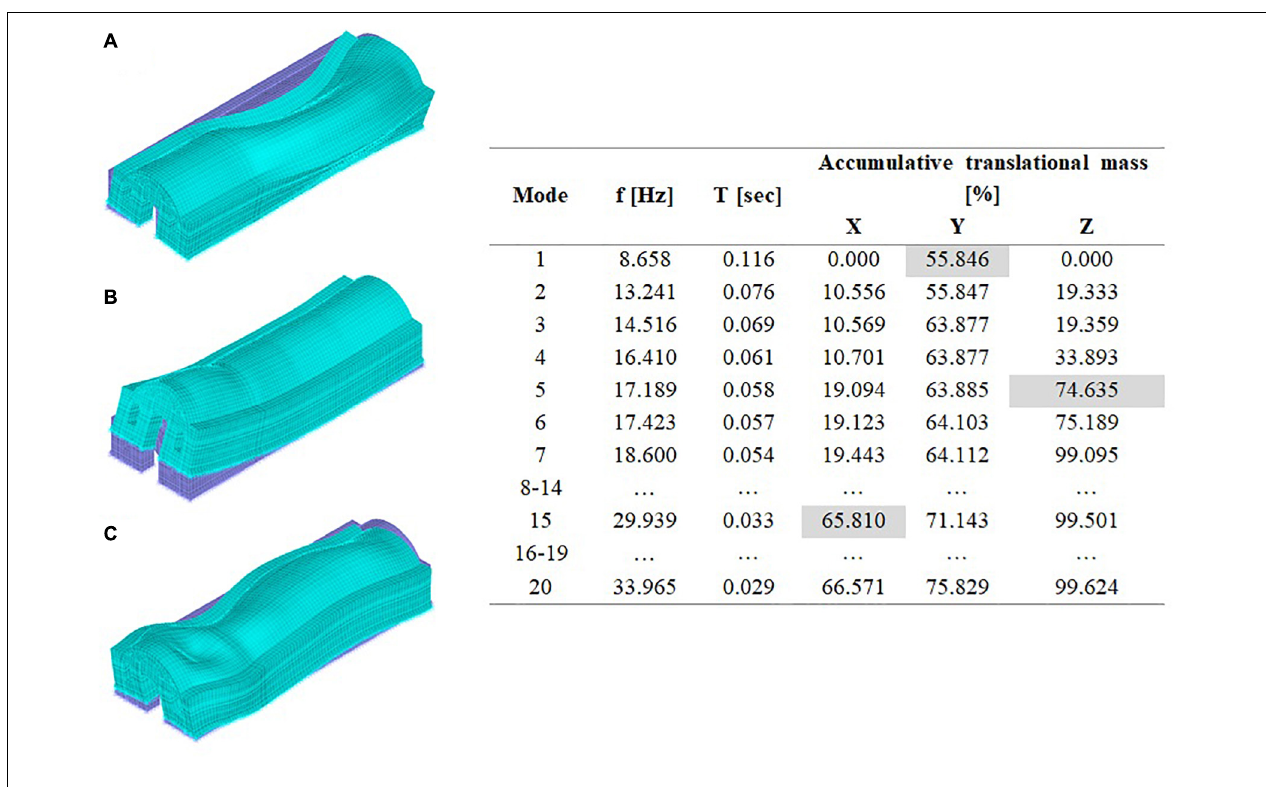
FIGURE 5 | (A) Y translation. (B) Z translation. (C) X translation.